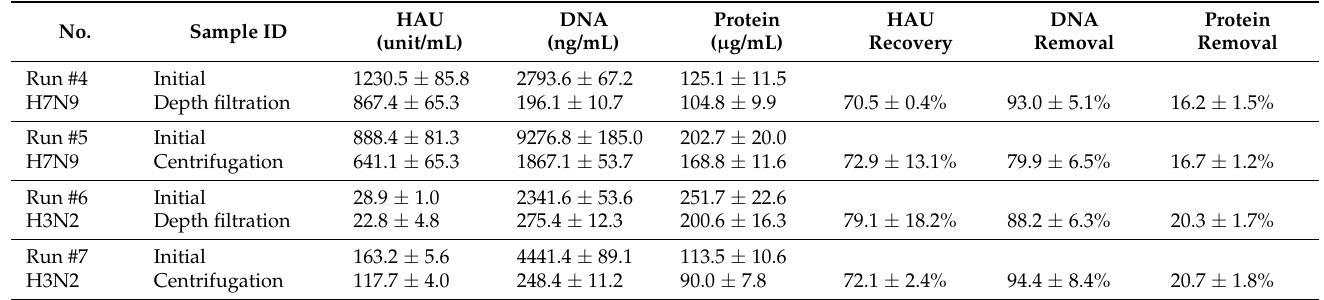
Table 5. Comparison of clarification methods between centrifugation and depth